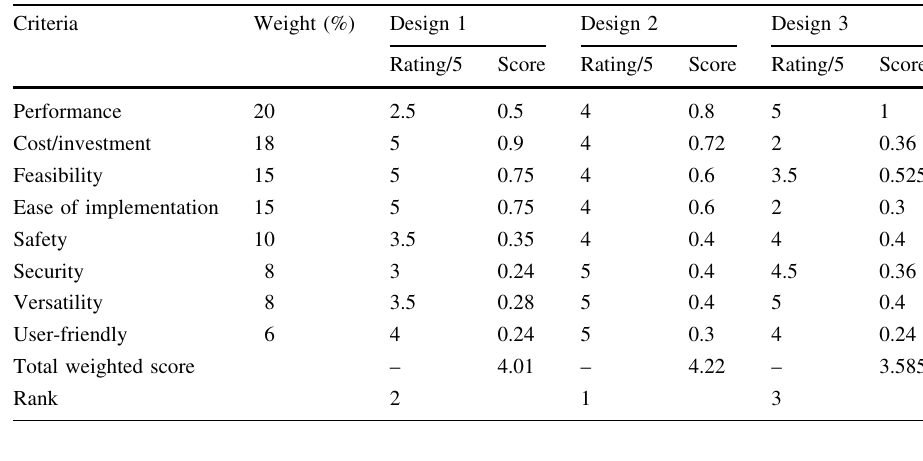
Table 2 Comparison of Design 2.1 to existing